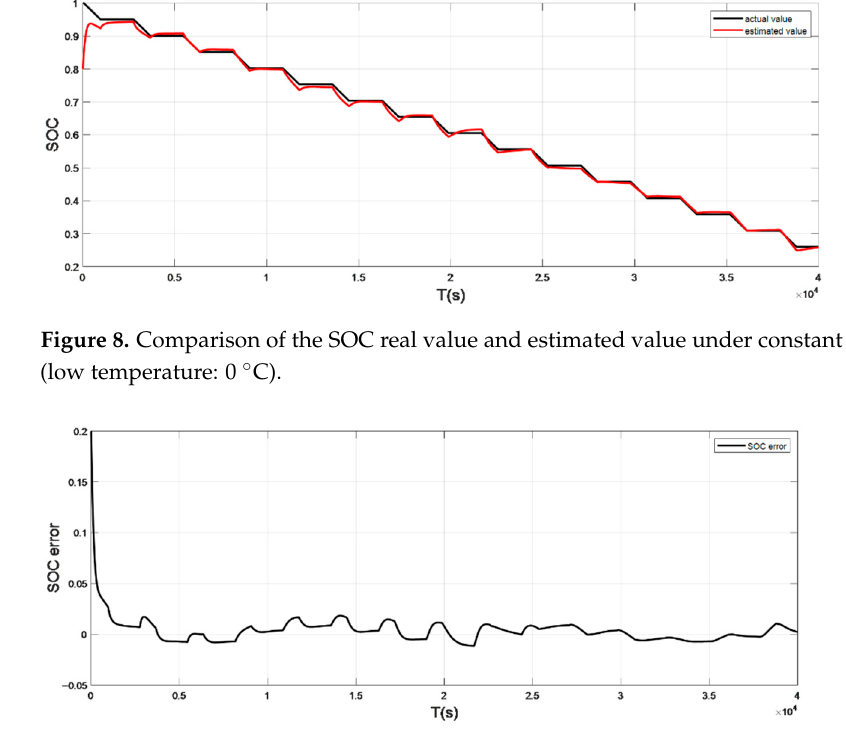
Figure 9. The SOC estimation error under constant current discharge (low temperature: 0 °C).